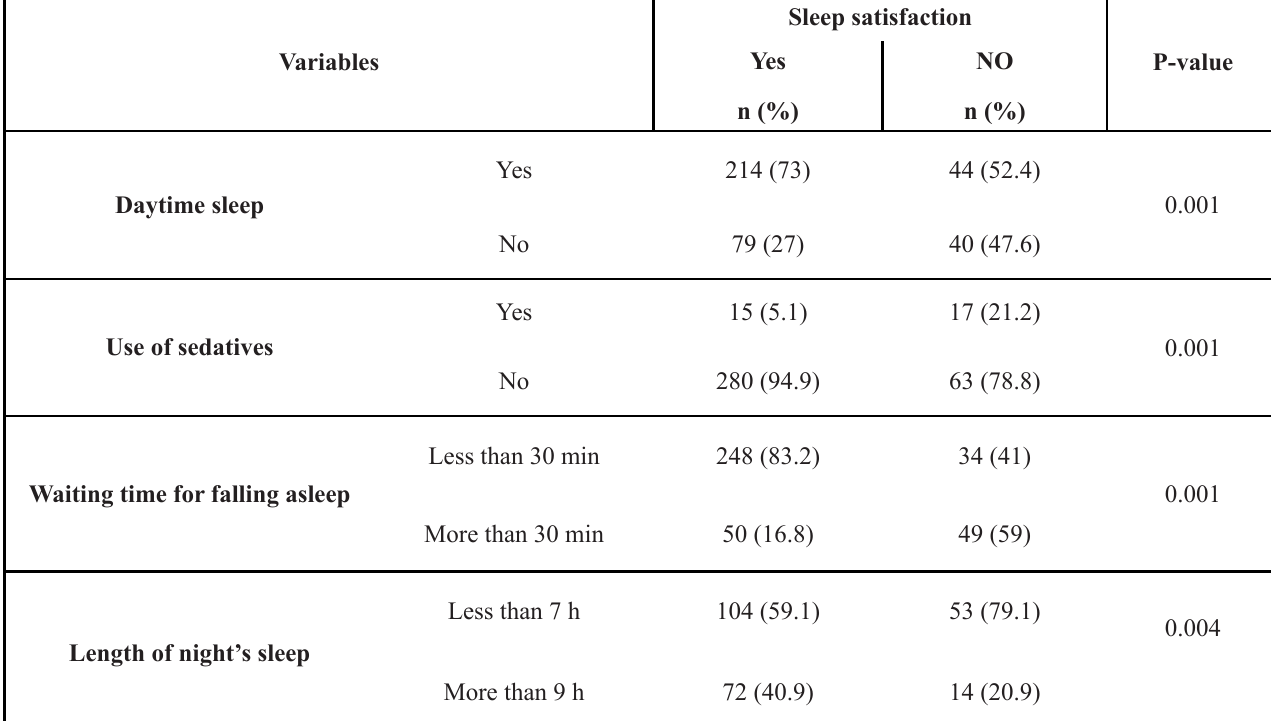
Table 1. The asoosiation between sleep satisfaction and variables of sleep pattern of individual